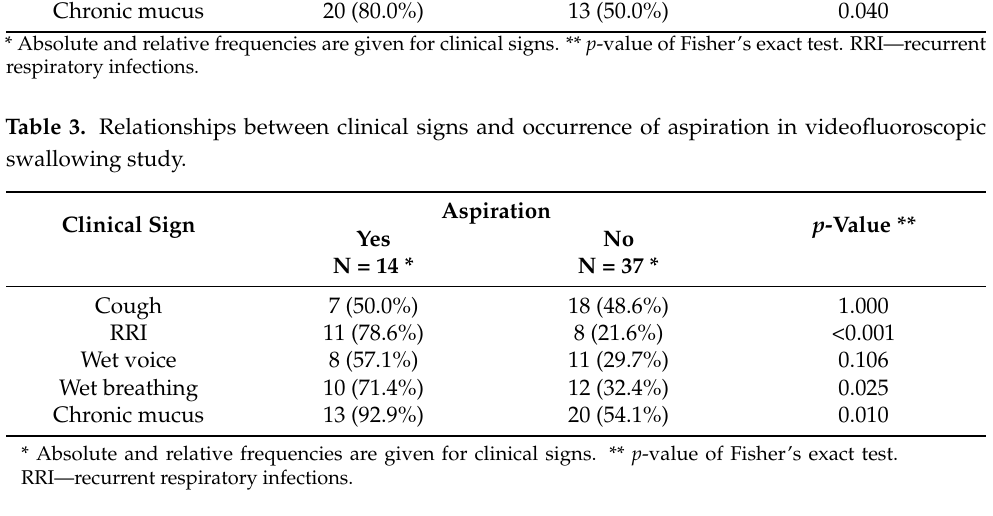
Table 4. Relationships between clinical signs and occurrence of nasopharyngeal penetration in videofluoroscopic swallowing